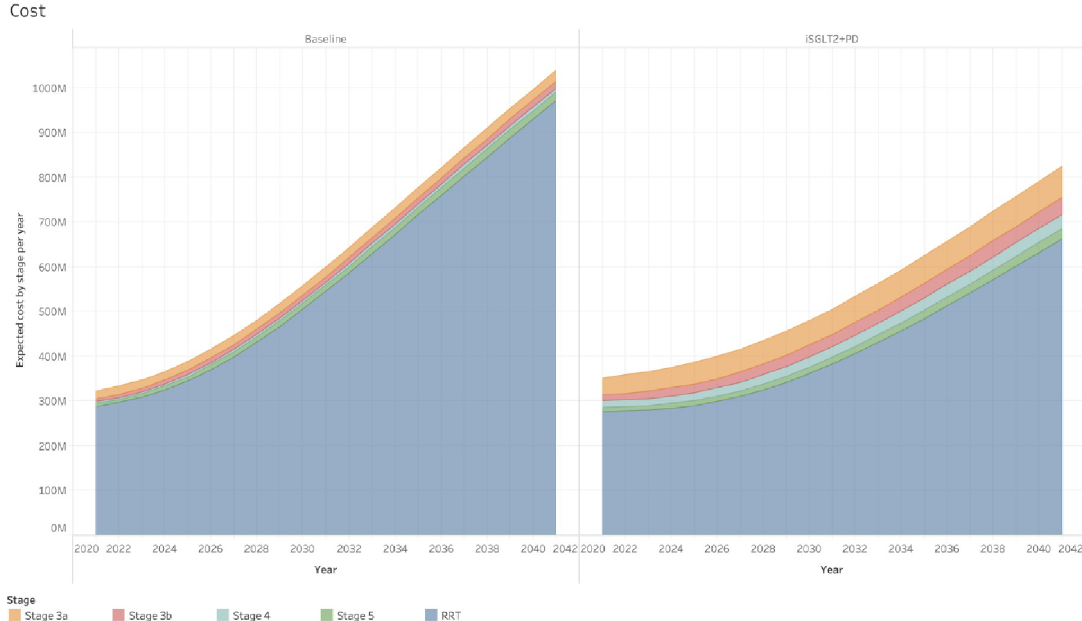
Fig 4. Expected costs per year, CKD stage and scenario. Comparison of expected costs (in Million GBP) between the two scenarios simulated in the study. The difference in the proportion of fast, medium and slow progressors between stages creates a difference in the distribution of individuals between them and therefore the healthcare costs. In the baseline scenario, with a greater number of individuals progressing faster to RRT, the total costs of CKD projected to 2041 is higher compared to the scenario with the inclusion of SGLT2 inhibitors for individuals with CKD stages 3a and 3b and with diabetes mellitus, and pre-dialysis treatment for individuals with CKD stages 4 and 5.